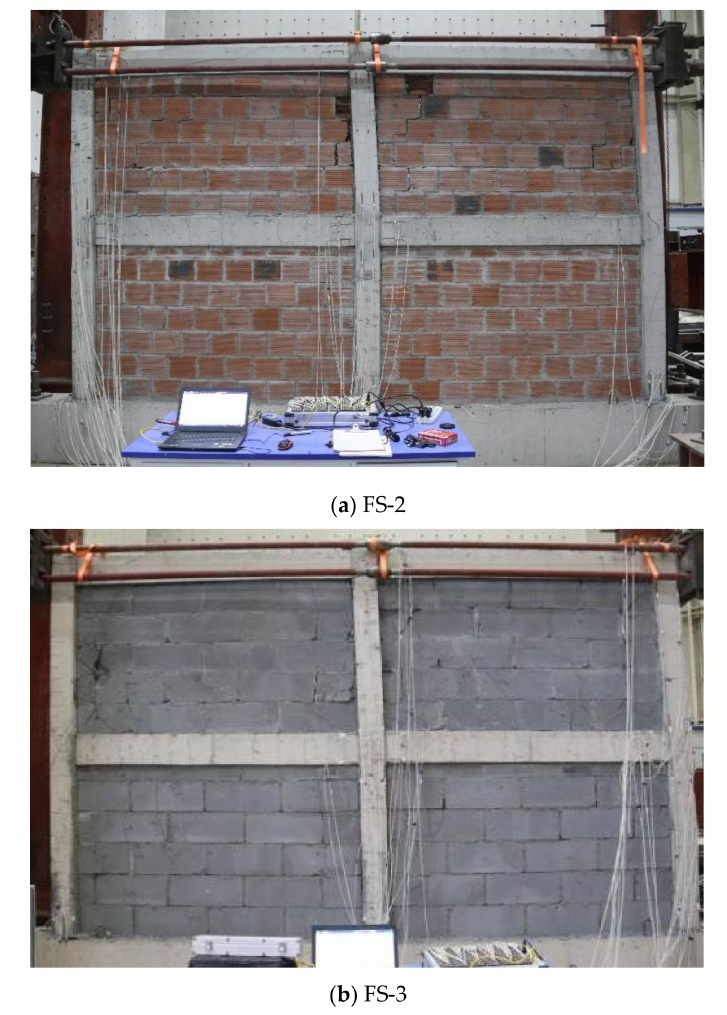
Figure 8. Crack patterns of infill